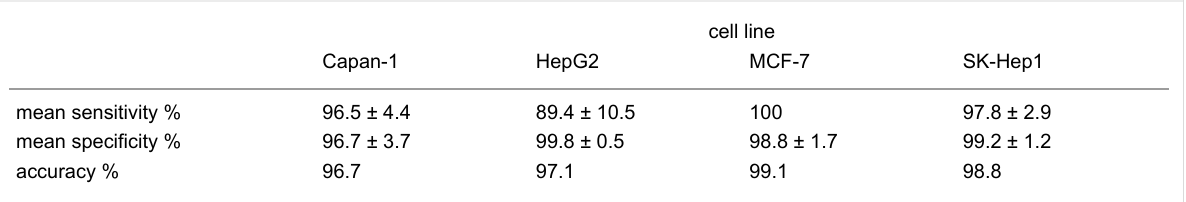
Table 2: Mean sensitivity, specificity and accuracy values of support vector machine model for each cell line (in percentage).